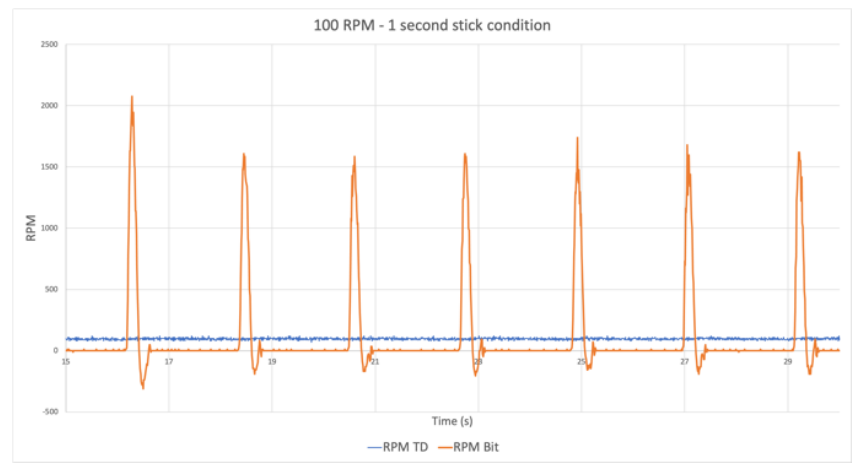
Figure 23. Tests at 100 RPM (1 s and 5 s bit sticking).